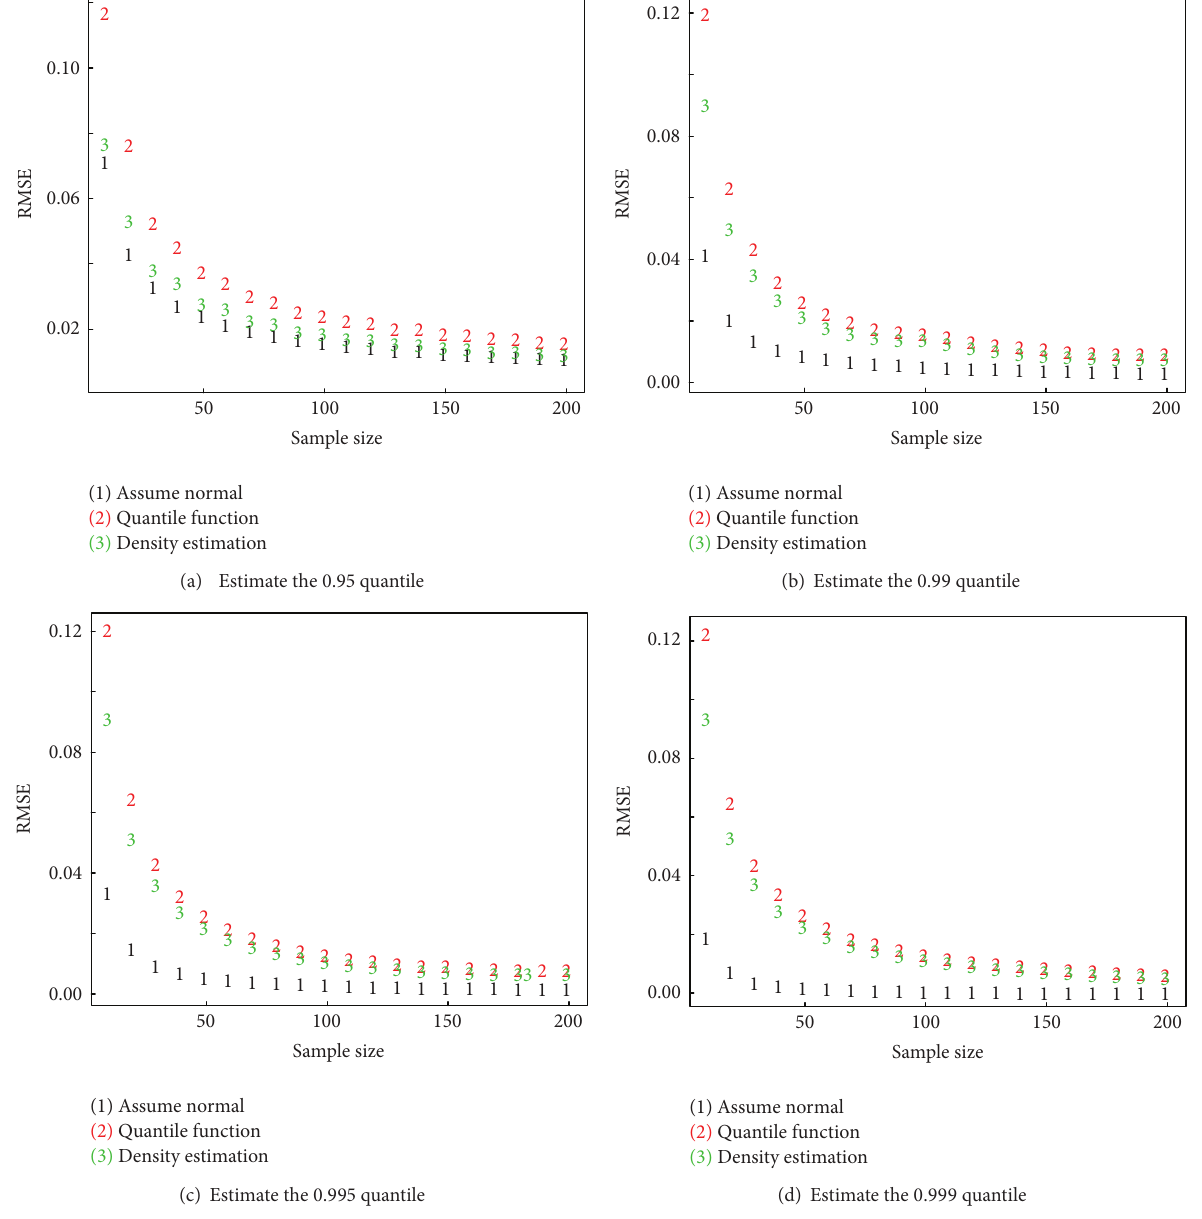
Figure 10: RMSE versus sample size assuming a normal distribution for three estimation options labeled 1–3. The true RMSEs were estimated by simulation of 10 4 observations in R , and results are repeatable to within ±0.001 . Option 1 correctly assumes a normal distribution. Option 2 uses the quantile function in R . Option 3 is density estimation as discussed in Section